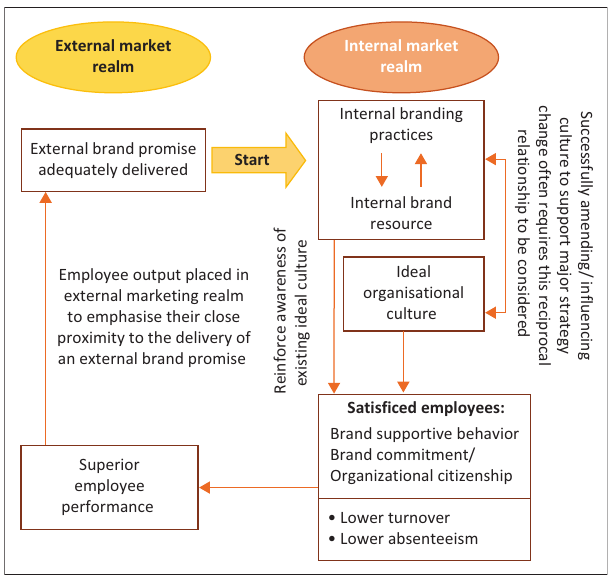
FIGURE 1: Suggested link between the external and internal